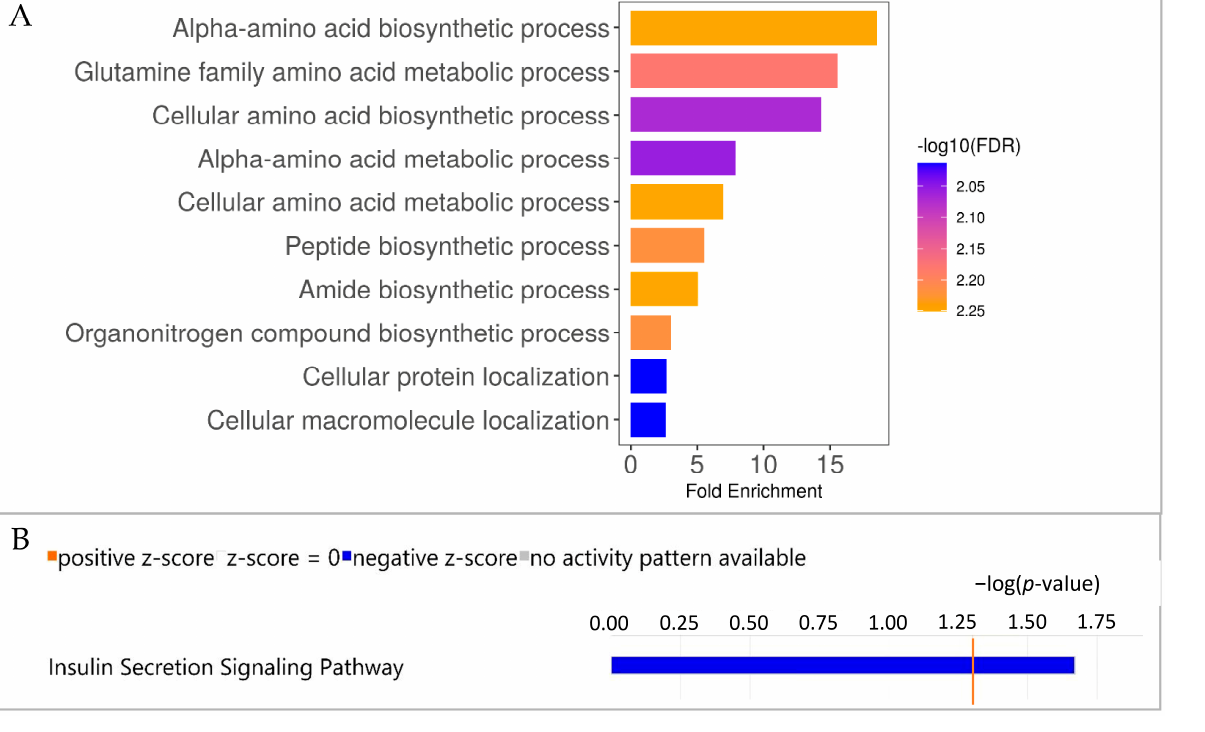
Figure 3. Pathway enrichment analyses of divergent proteomic profiles in CD4 + PBMC of GHR - KO/WT pigs. ( A ) Pathway enrichment analysis using ShinyGO software showing the 10 pathways with the highest fold enrichment. Enrichment analysis of differentially abundant proteins in CD4 + PBMCs revealed the highest enrichment of “Alpha-amino acid biosynthetic process” and in GHR - KO pigs. The length of the bars represents the fold enrichment, and the color of the bars represents the FDR. ( B ) Pathway enrichment analysis using Ingenuity Pathway Analysis (IPA). The bar chart shows all enriched pathways with a prediction for activation or inactivation. Negative (blue) z-score indicates inactivation predicted by IPA. Color intensity correlates with z-score, while bar length indicates statistical signi fi cance. The orange, vertical line represents the –log ( p -value) threshold which was 1.3.